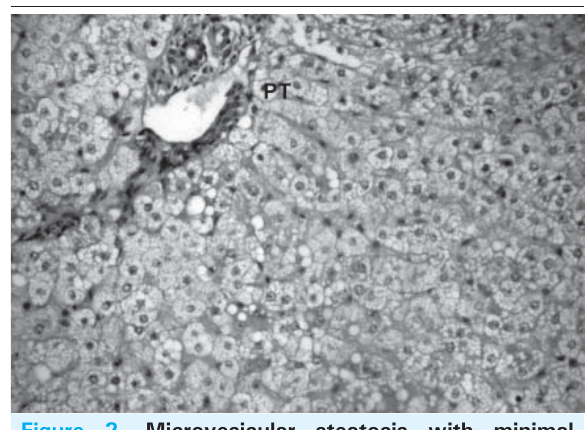
1000XFigure 2. Microvesicular steatosis with minimal in fl ammation and absence of bile ductular proliferation and bile stasis. PT, Portal tract. H & E, 200X